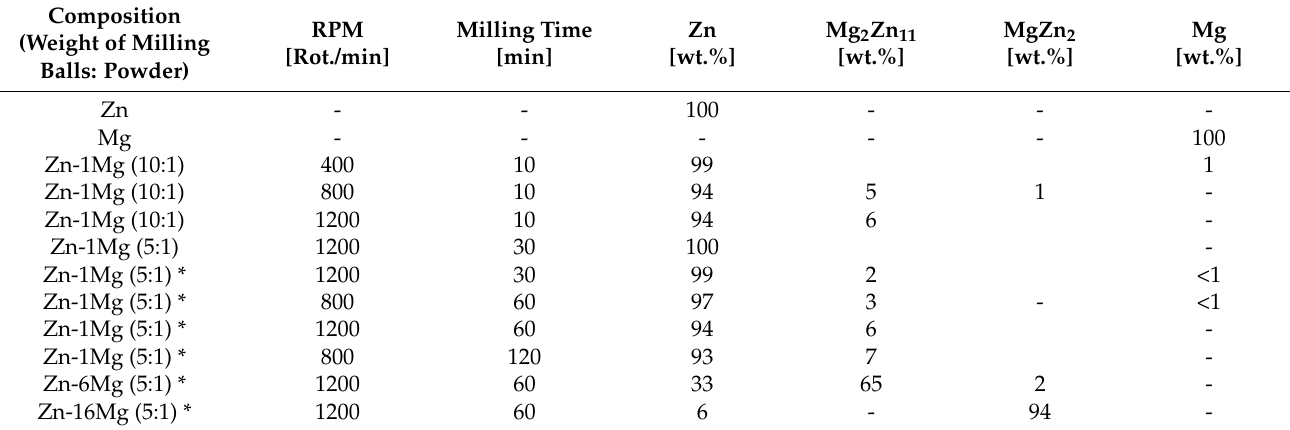
Table 3. Phase composition of the Zn-Mg alloys prepared by mechanical alloying (XRD analyses).